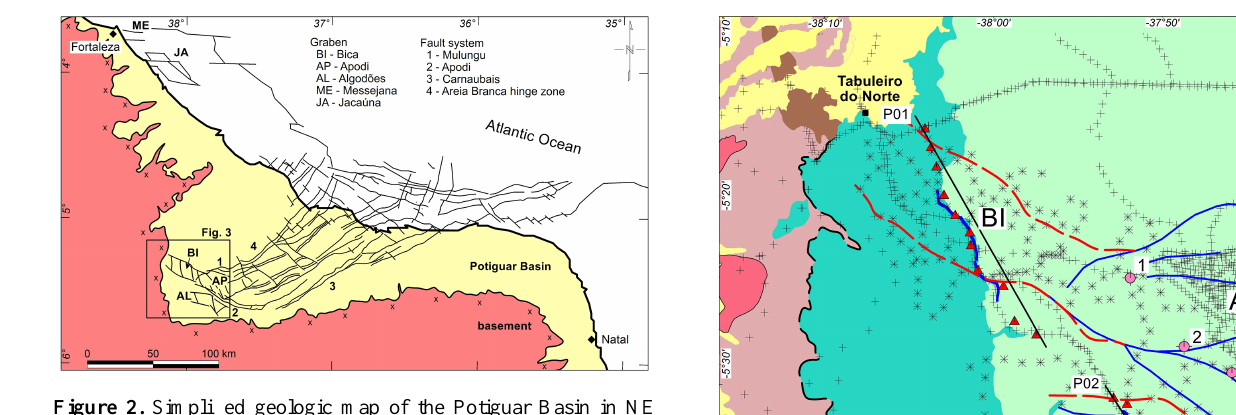
Figure 2. Simplified geologic map of the Potiguar Basin in NE Brazil (adapted from Angelim et al., 2006). The rift structures in the maps of Figs. 2 and 4 are inferred from interpretation of seismic sec- tions and well logs, conducted by Matos (1992) and Borges (1993). The grabens located at the SW rift termination are derived from the present geophysical survey.